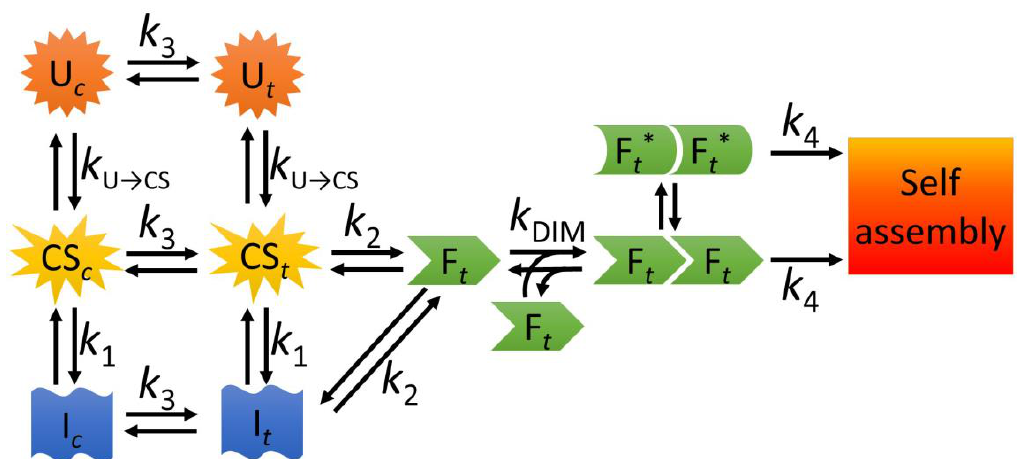
Figure 7. A model describing the folding, unfolding, dimerization and possible misfolding equilibria of NTD. U, unfolded state; CS, collapsed state; I, intermediate state; F, folded state. The subscripts t and c indicate the trans and cis configurations of one or more specific X-Pro peptide bond(s). F t *, a native-like state with distorted β-sheet structure.